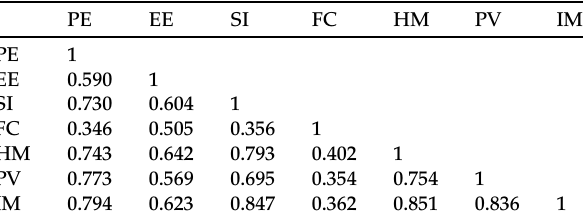
Table 2. . HTMT of the measurement model.